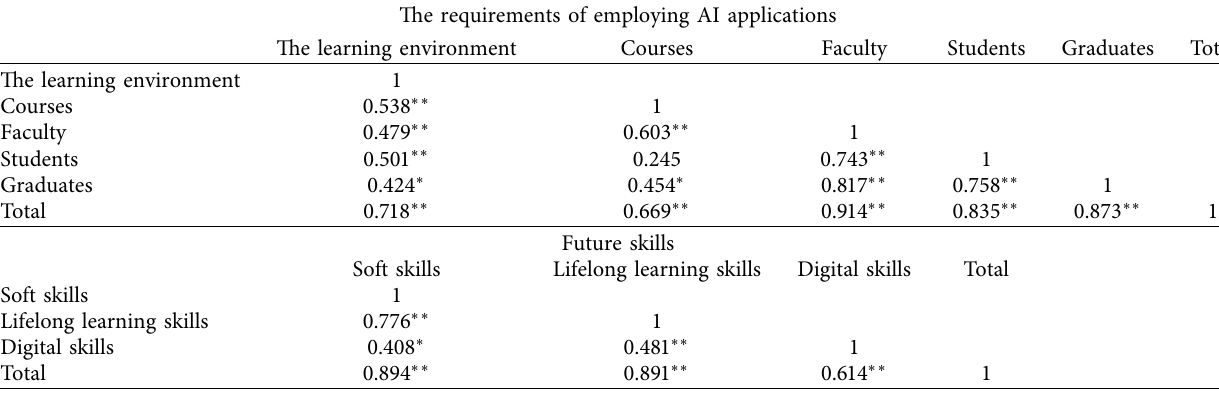
Table 2: Correlations among dimensions of the questionnaire.